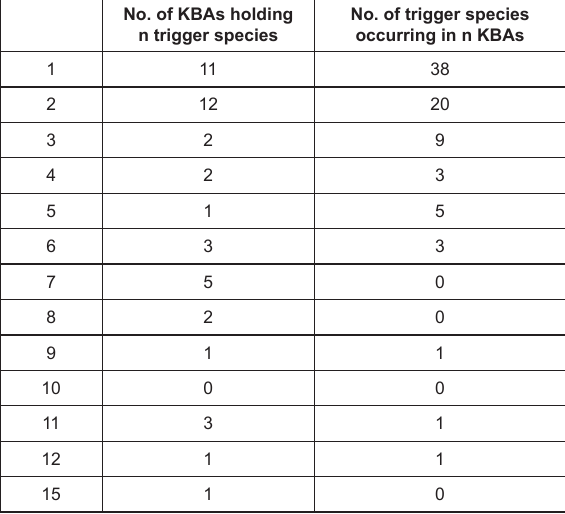
Table 3. Summary of frequency distributions of the number of trigger species (n) per KBA, and the number of KBAs per trigger